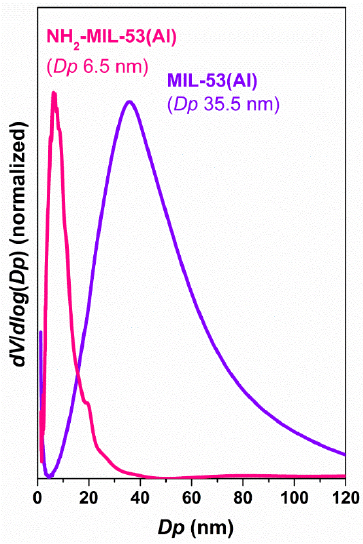
Figure A2. The Barrett-Joyner-Halenda (BJH) pore size distribution (PSD) of NH 2 -MIL-53(Al) and MIL-53(Al) materials arisen from the adsorption branch. Estimated PSD maxima indicated in brackets.